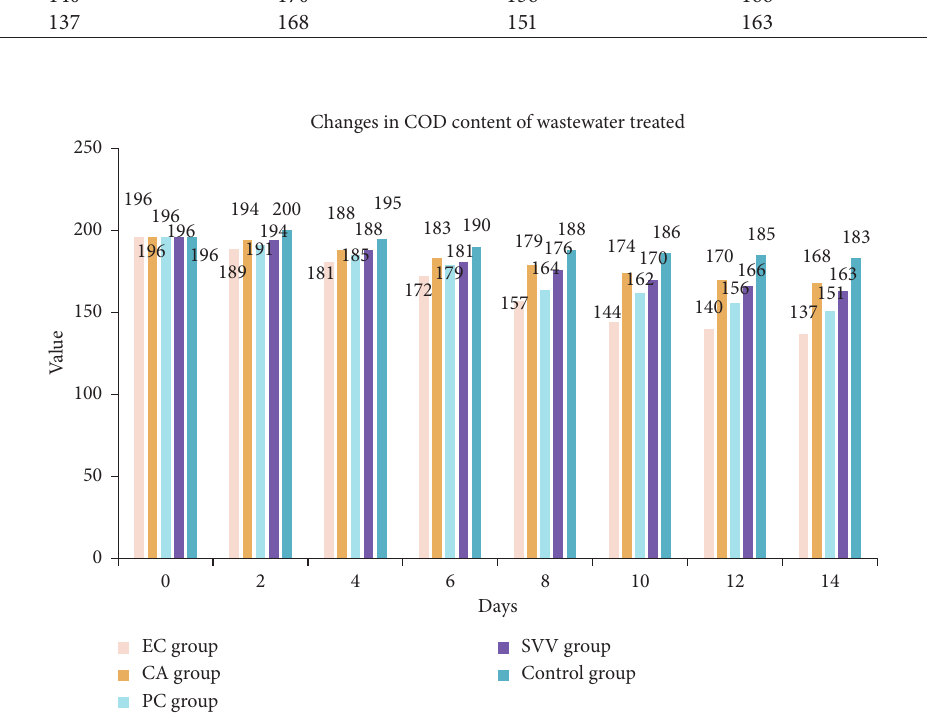
Figure 3: Changes in COD content of wastewater treated by